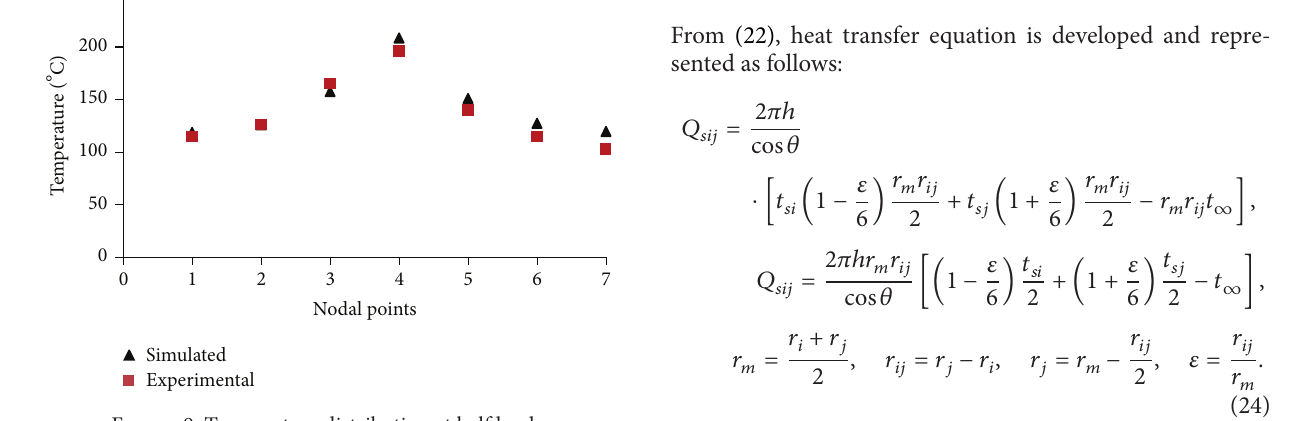
Figure 9: Temperature distribution at half load.